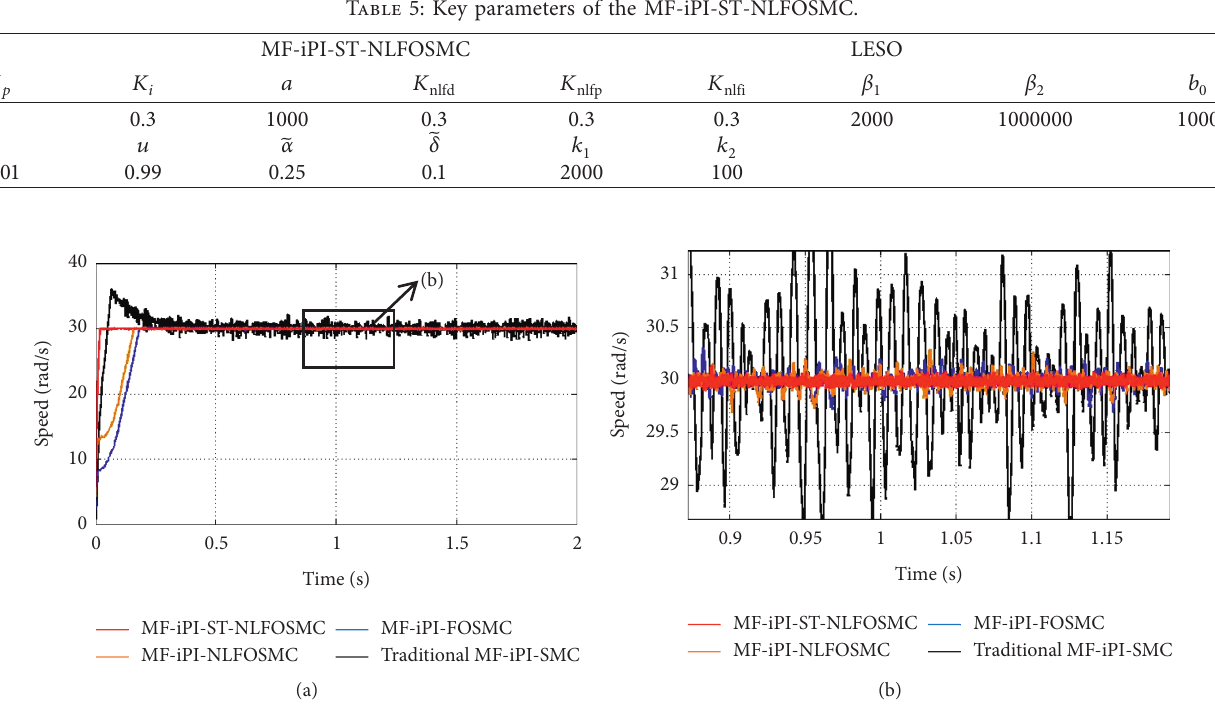
Figure 4: (a) Speed response curves under the traditional MF-iPI-SMC, the MF-iPI-FOSMC, the MF-iPI-NLFOSMC, and the MF-iPI-ST- NLFOSMC without load. (b) Magnification pictures of the speed response curves under the control strategies without